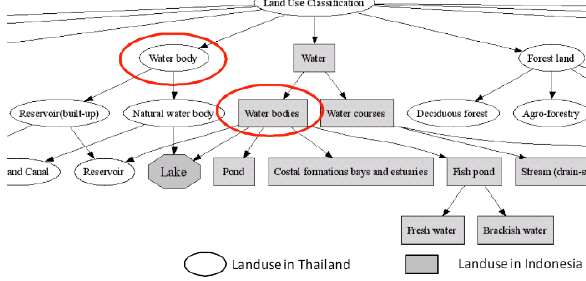
Figure 4. Graph representation for Landuse